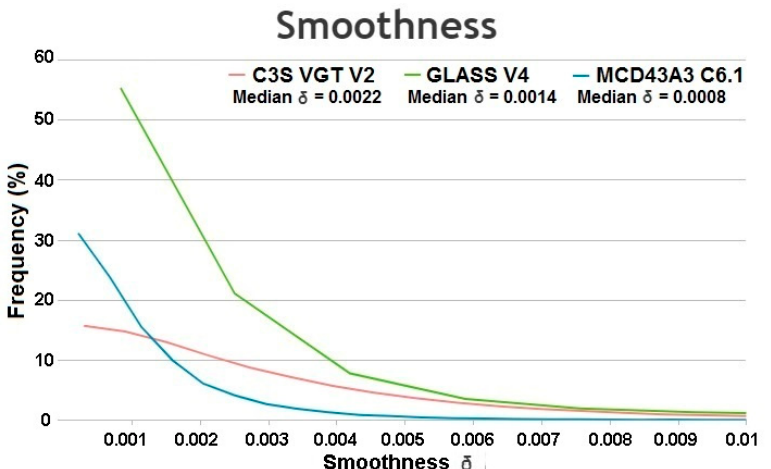
Figure 10. Histogram of the smoothness ( δ ) for C3S V2 (red), GLASS V4 (green), and MCD43A3 C6.1 (blue) total shortwave black-sky albedo products. Evaluation in the 2001–2005 period over LANDVAL sites considering all pixels. Table 8. Summary of median δ for C3S V2, GLASS V4, and MCD43A3 C6.1 total shortwave black-sky albedo products. Evaluation in the 2001–2005 period over LANDVAL sites considering all pixels.